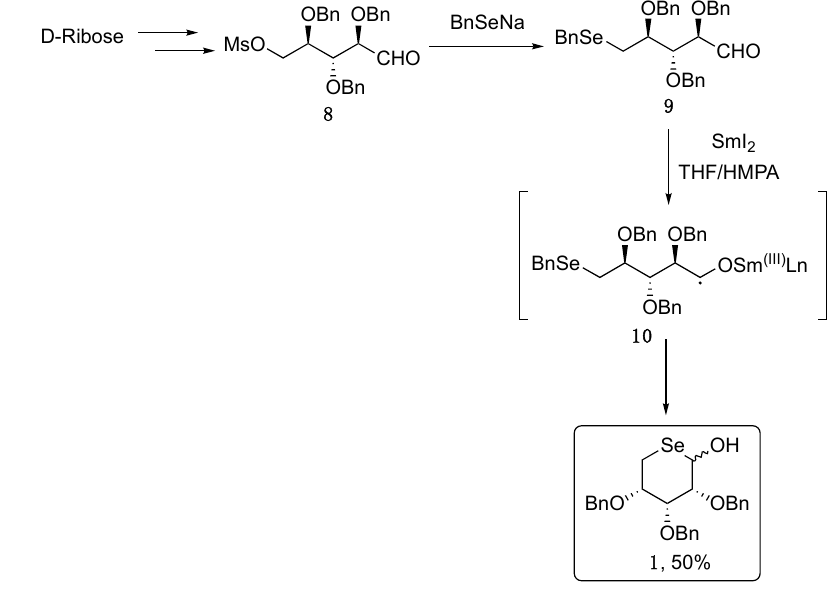
Scheme 1. Synthesis of compound 1 .